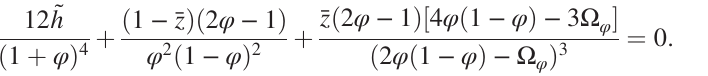
; ˜ J s Þ for the mean field and Bethe- crit crit ˜ h . The Bethe-Guggenheim approximation